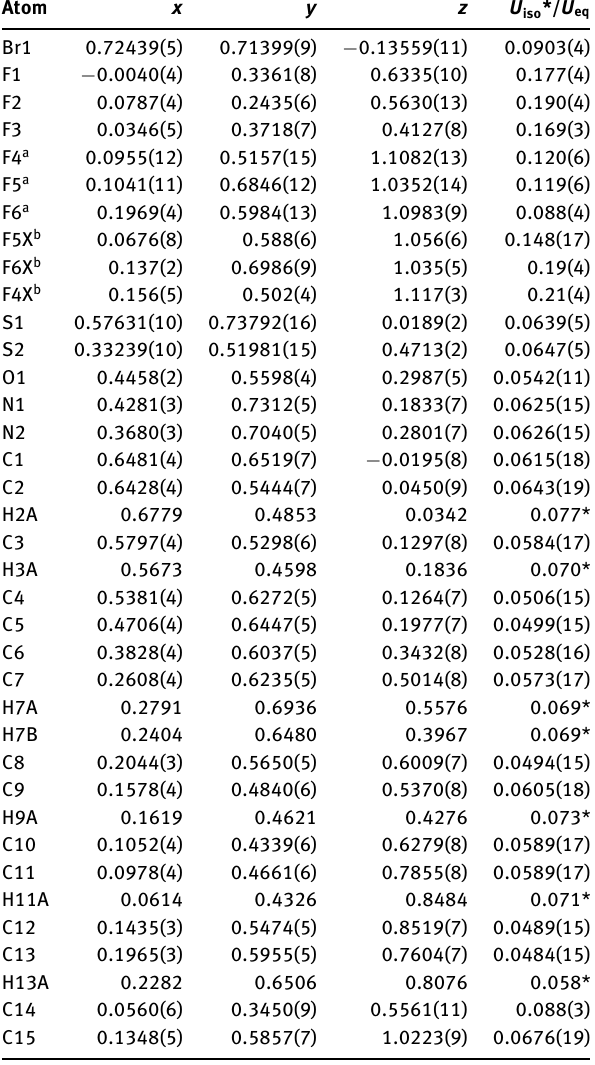
Table 2: Fractional atomic coordinates and isotropic or equivalent isotropic displacement parameters (Å 2